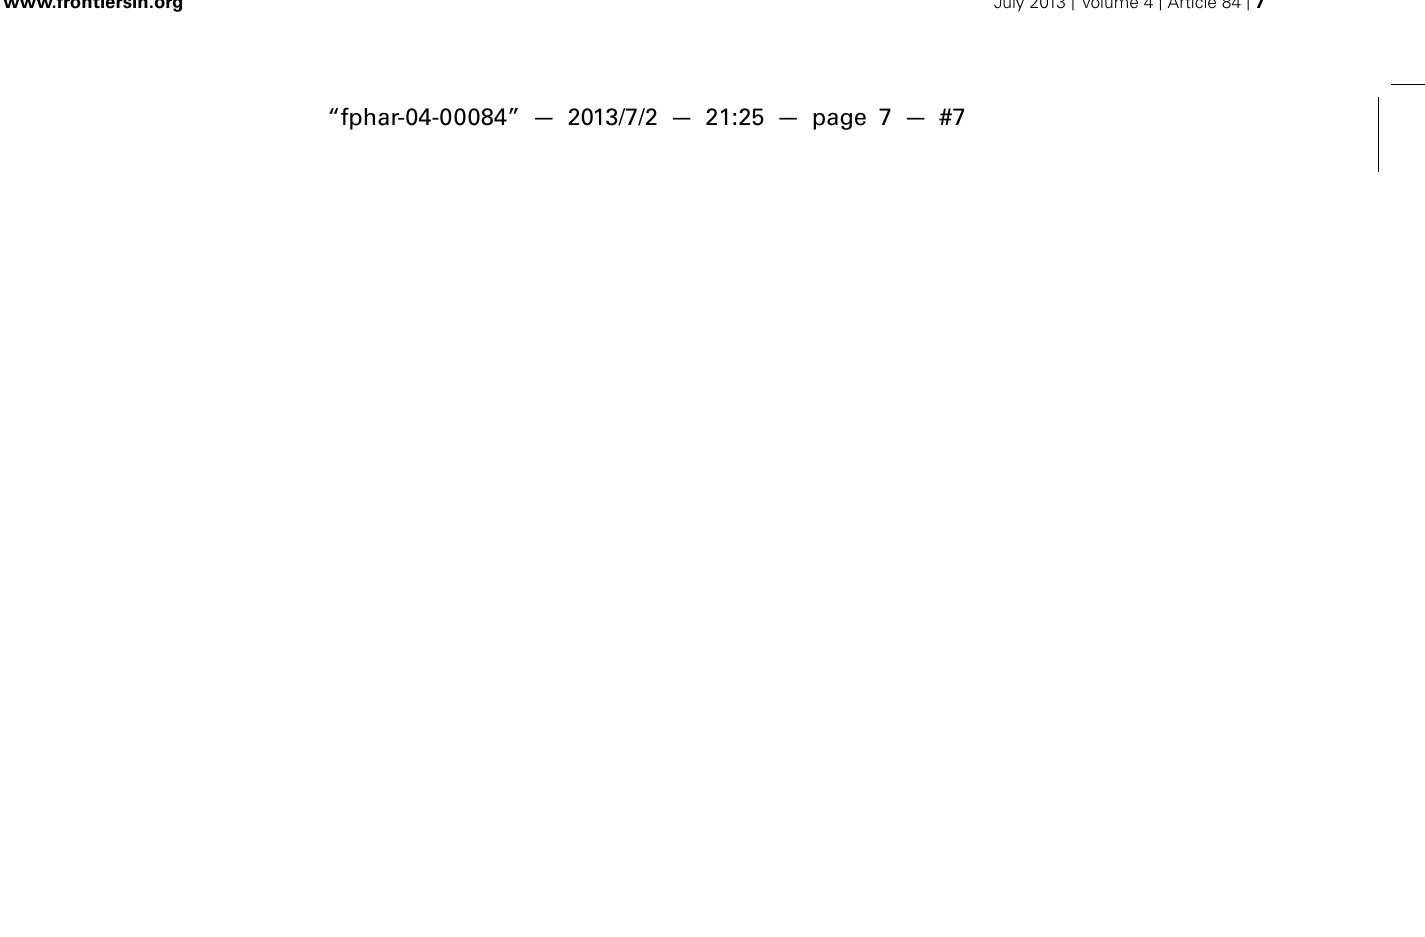
proportion of close bouts relative to the lowest number of bouts one subject exhibited does not significantly differ between housing conditions or group changes, and there is no significant interaction of